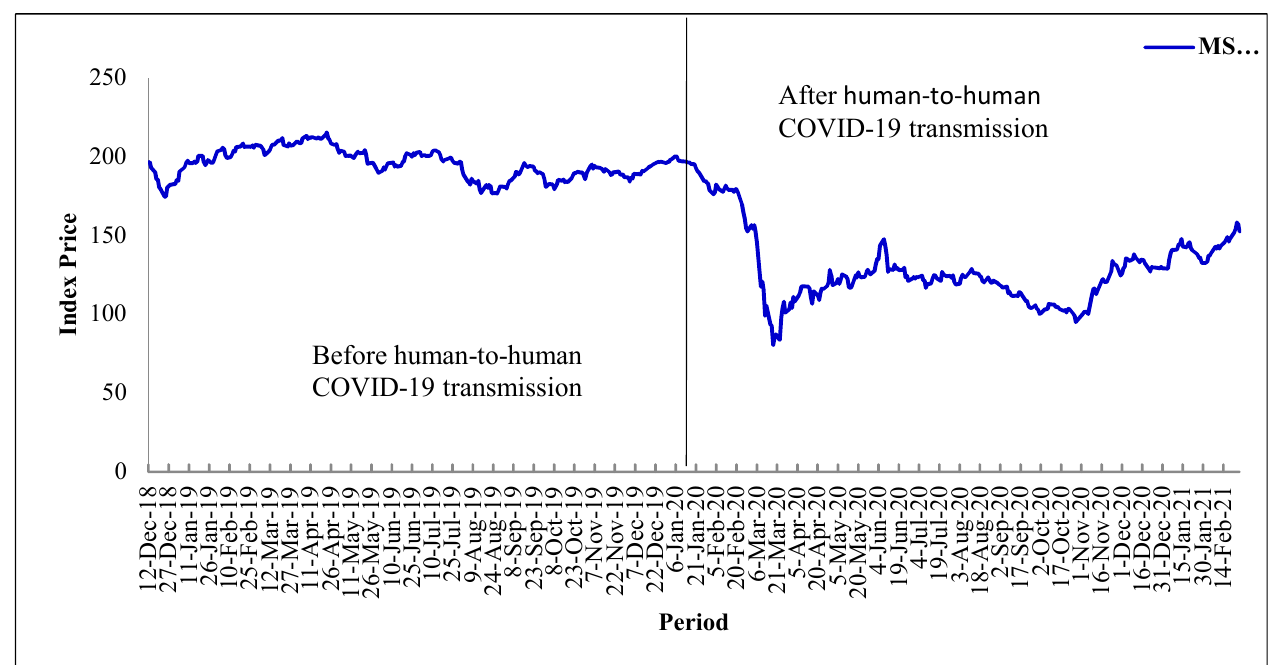
Figure 4. Daily movements of MSCI world energy index (MSCIE).